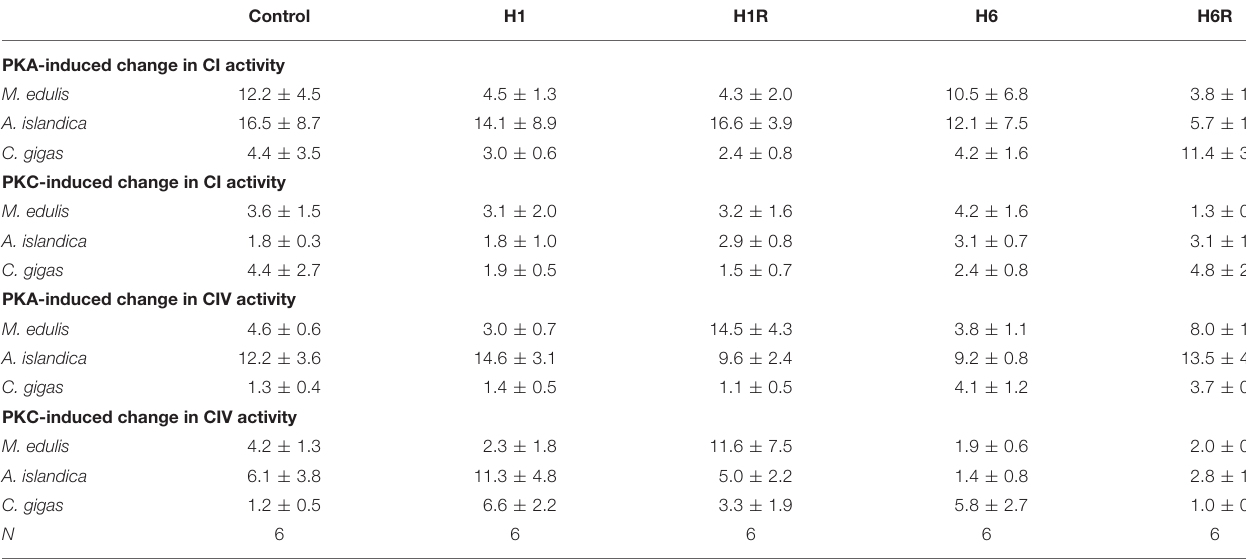
TABLE 4 | Inducibility of CI and CIV activity by PKA and PKC-dependent phosphorylation relative to the dephosphorylated state. Control